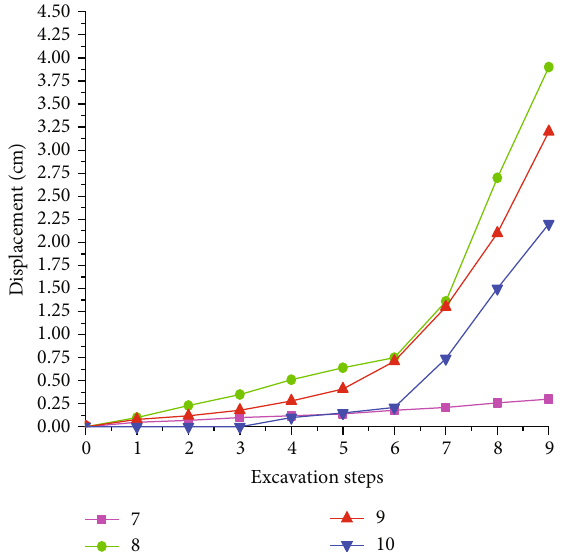
Figure 17: The changes of the slope displacement with rainfall time.